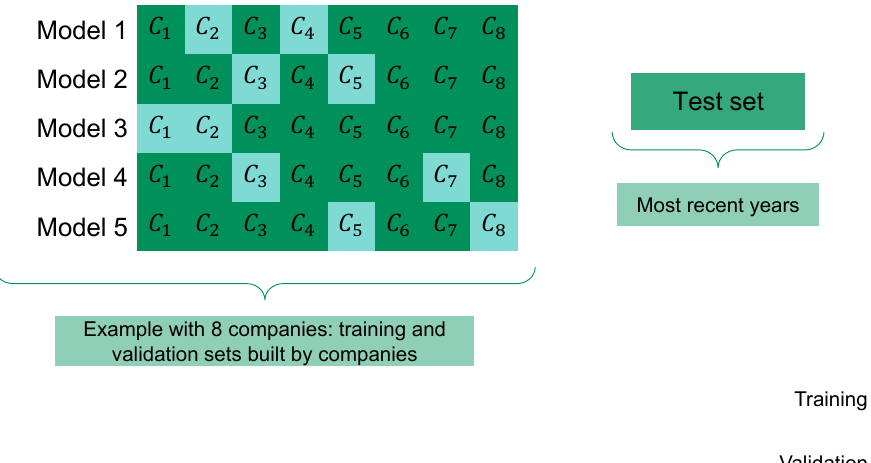
Figure 5. Company-wise cross-validation: the validation sets consist of randomly selected companies, which allows training to account for most of the most recent